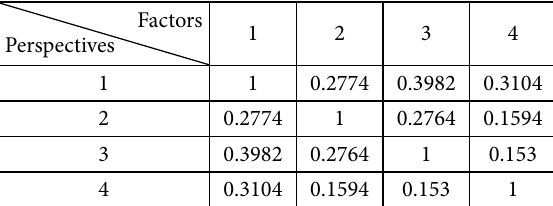
Table 8. Correlation between factor scores Factors